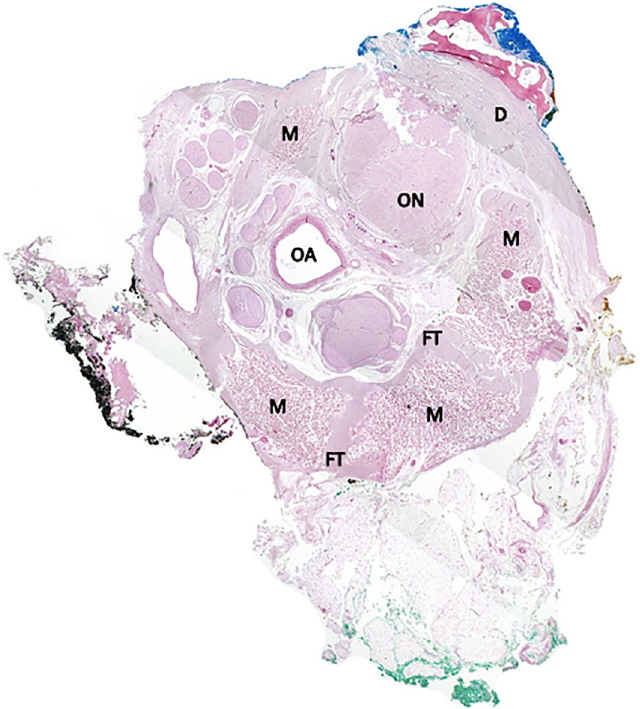
Figure 4. Composite image of histological slides, right orbit. Optic nerve (ON), the ophthalmic artery (OA) is surrounded by oculomotor foramen structures (abducens nerve, nasociliaris nerve, two branches of oculomotor nerve), the skeletal muscle fibres of the extraocular muscles (M) are separated by thin layers of fibrous tissue (FT), the annular fibrous tissue (annulus of Zinn) is continuous with the skull base dura (D).